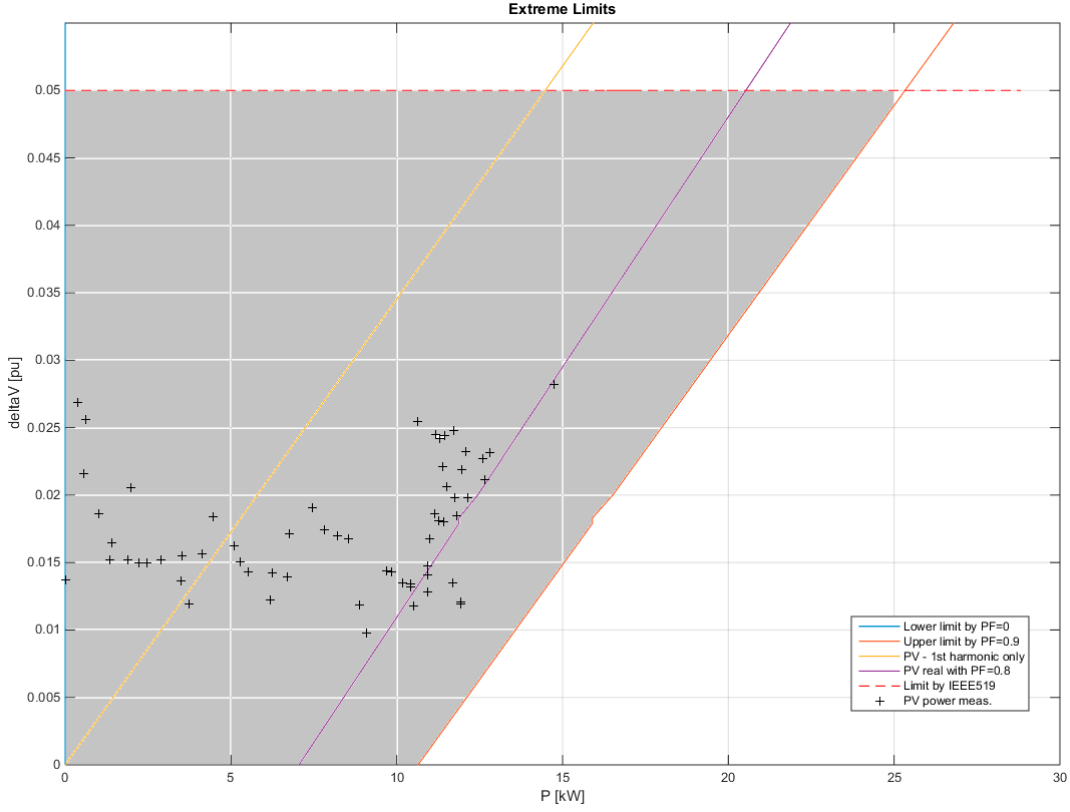
Figure 6. Hosting capacity approach of the four scenarios.